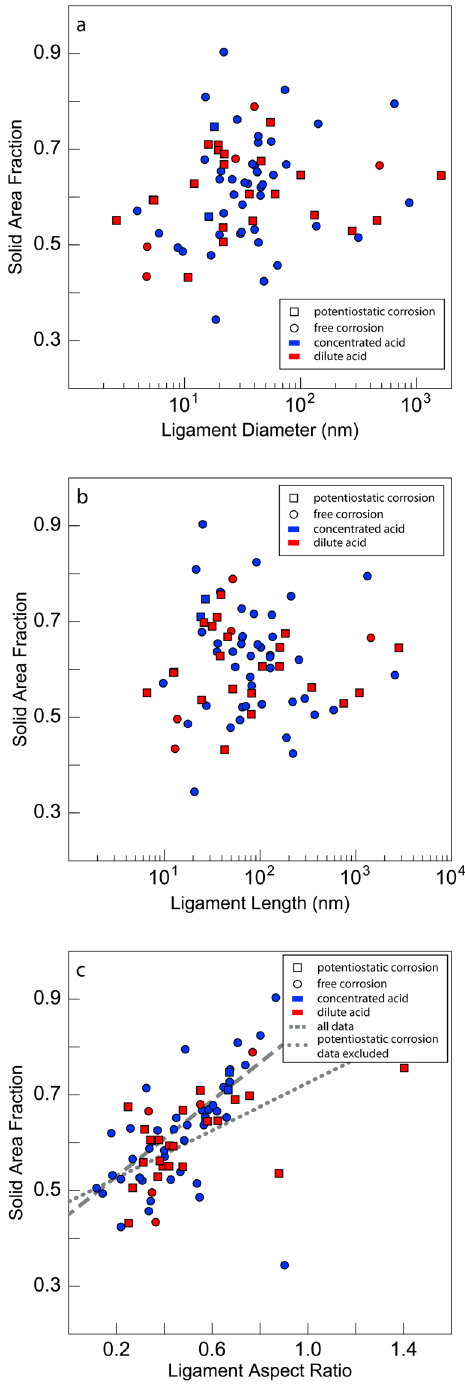
Figure 5. Area fraction versus morphological descriptors of NPG. ( a ) Ligament diameter, ( b ) ligament length, and ( c ) ligament aspect ratio (ligament diameter/ligament length). The lines in ( c ) are a linear least squares fits to the data. While there is no apparent correlation between the area fraction and either the ligament diameter or ligament length, there is a linear correlation between the solid area fraction and ligament aspect